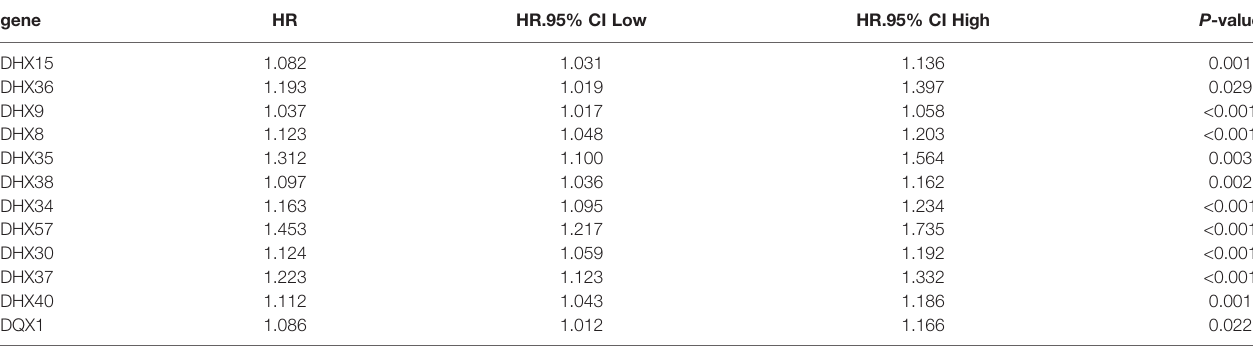
TABLE 2 | Univariable Cox regression analysis for screening prognostic genes.